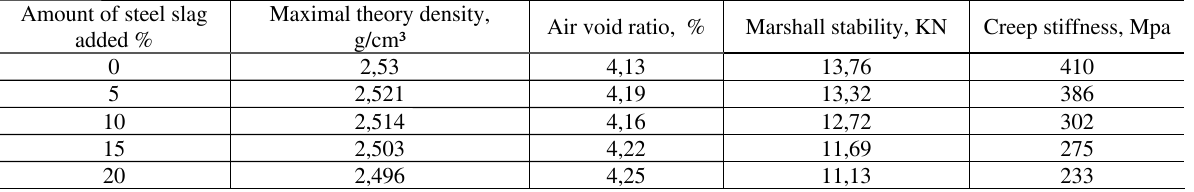
Table 2. Marshall test results for different steel slag replacement Maximal theory density, Amount of steel slag Air void ratio, % Marshall stability, g/cm³ added %